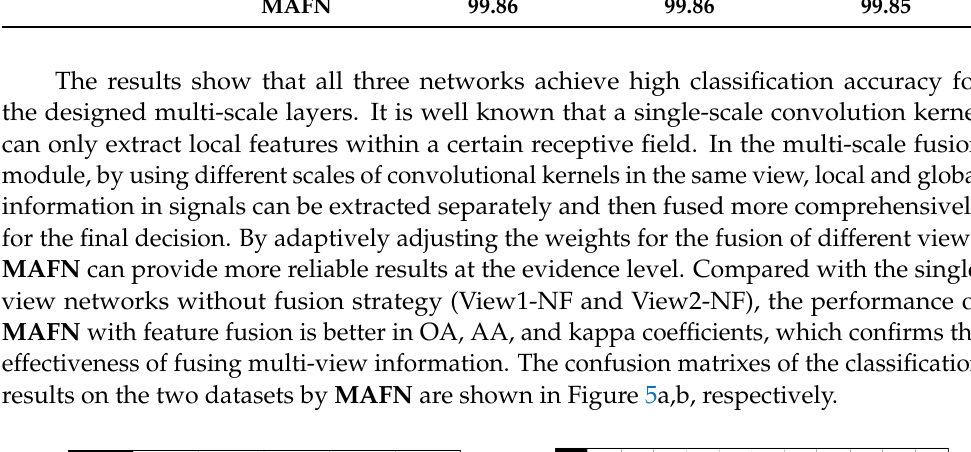
(b) Figure 6. The classification accuracy curves of MAFN and its counterparts under different SNRs. ( a ) Accuracy curve of MAFN with different SNRs. ( b ) Accuracy curve of comparison methods. 3.3. Investigation on the Multi-Scale and Fusion Module 3.3.1. Multi-Scale Module In this section, we analyze the role of the multi-scale fusion module and the decision- level fusion module separately. First, the multi-scale feature fusion part is removed, and the results of different views go through the feature extraction backbone, the classification layer, and the decision-level fusion layer, which is denoted as MAFN-no M. The